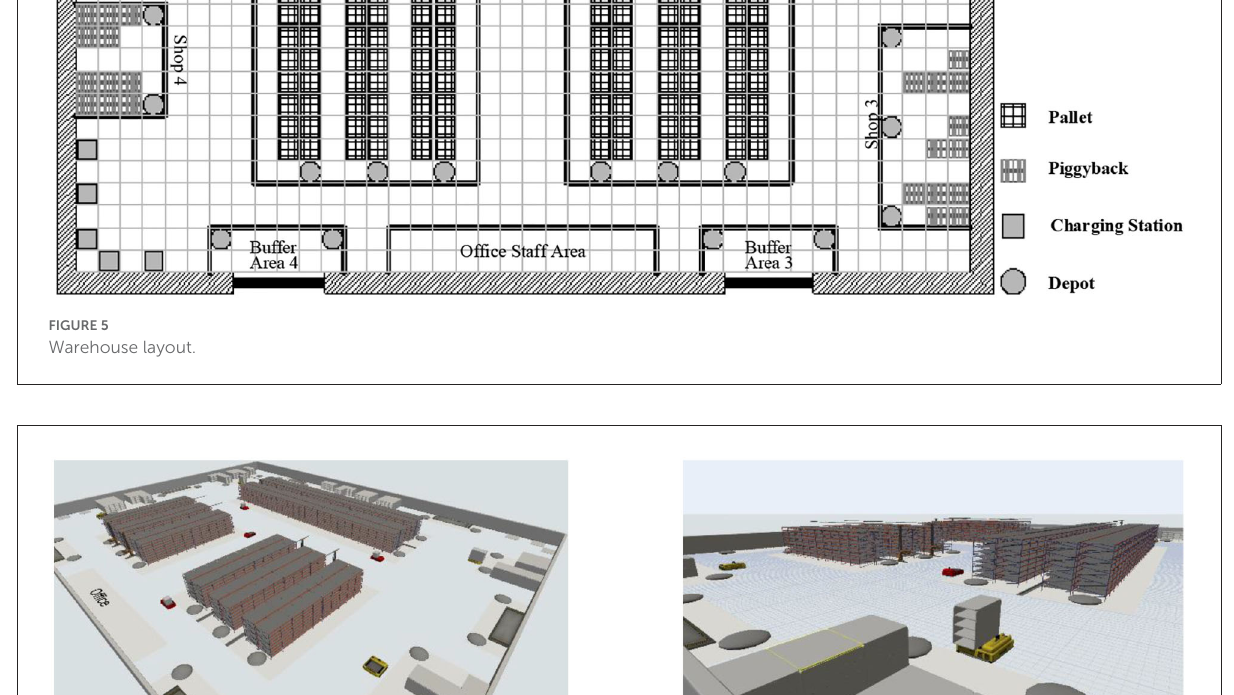
FIGURE6 FlexSim-based digital simulation